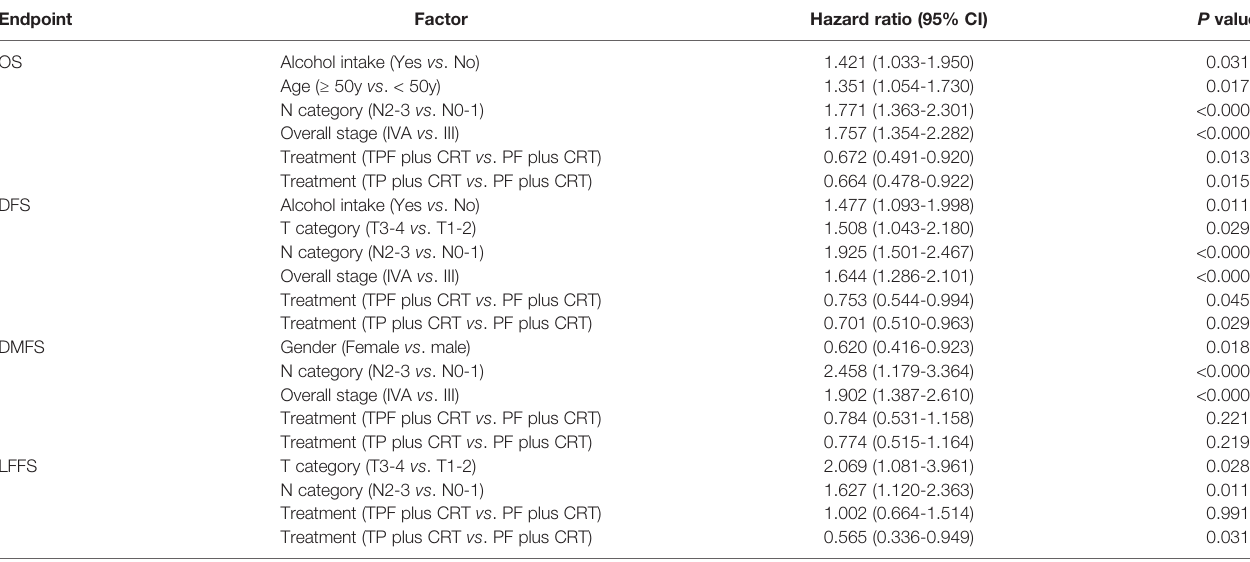
TABLE 2 | Results of multivariate